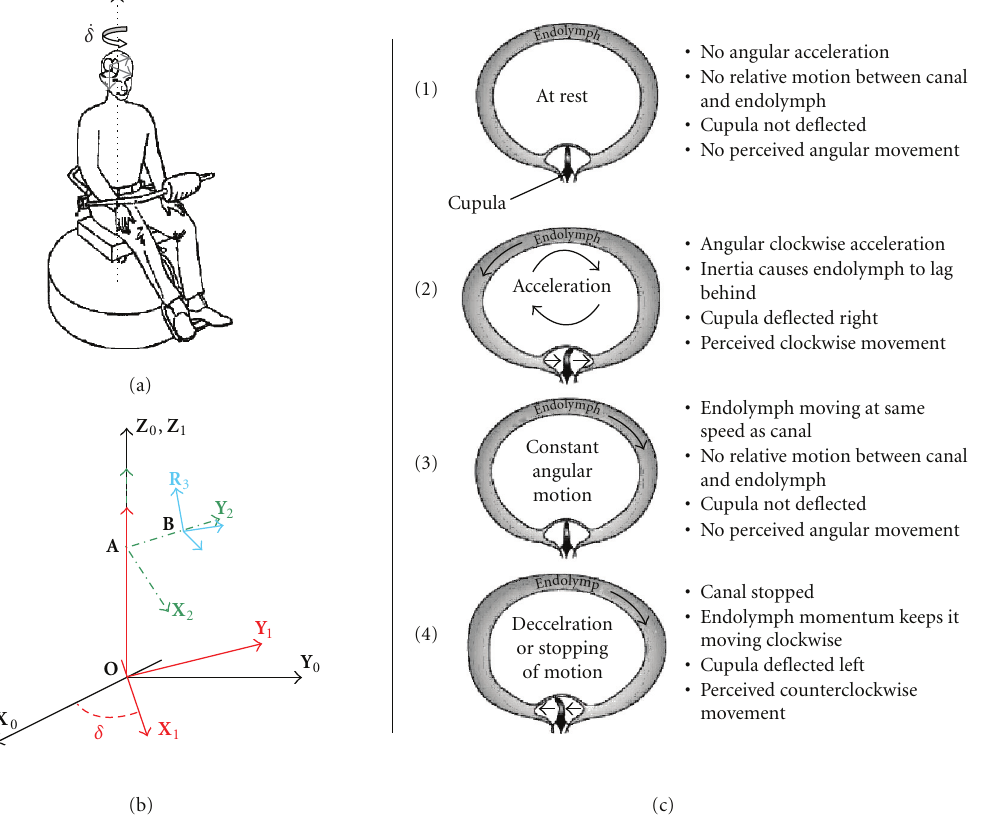
−→ −→ −→ X 0 , Y 0 , Z 0 ) fixed orthogonal